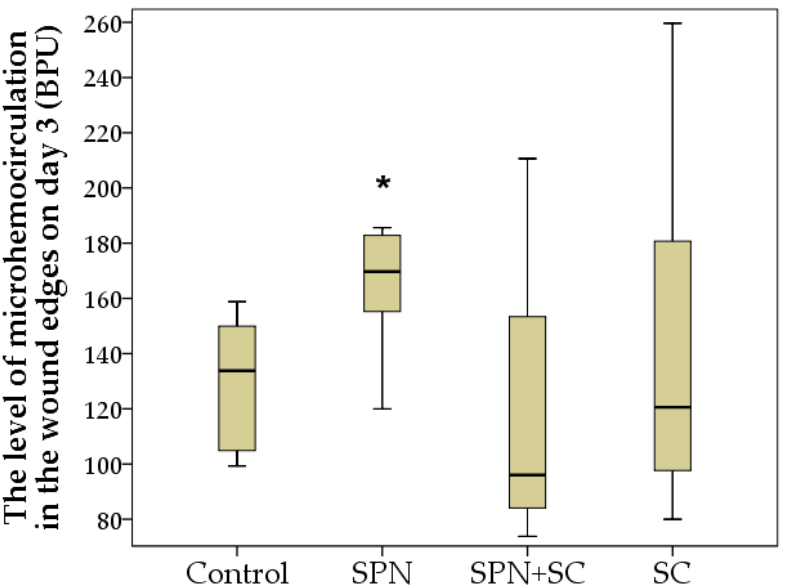
Figure 8. The level of microhemocirculation in the wound edges in different groups on day 3 (BPU). Notes: *—difference from the control group at p < 0.05. Post hoc analysis score (Dunnett’s t -test). Data are presented as median and interquartile range.